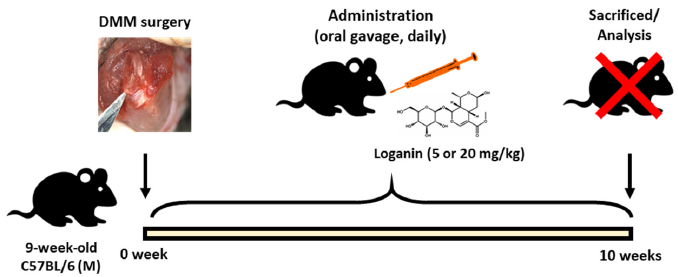
Figure 5. Schematic diagram of the animal study.